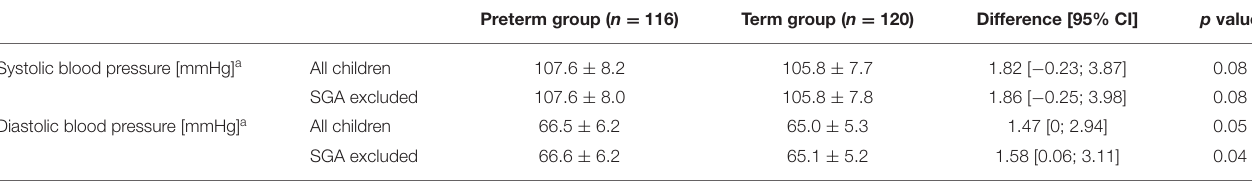
TABLE 2 | Raw blood pressure values in children born preterm and children born at term.